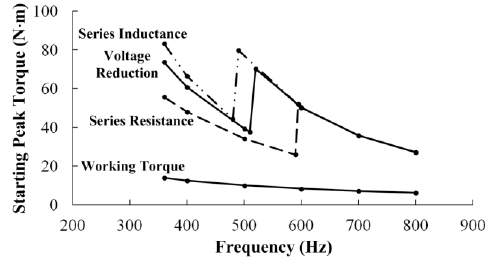
Figure 7. Starting peak torque characteristics with the low-frequency step-down starting.